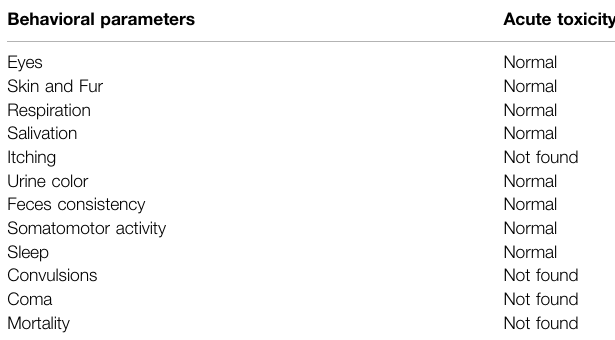
TABLE 1 | Behavioral changes after treatment with a single dose of SF1 (2000 mg/kg) in acute oral toxicity study. Behavioral